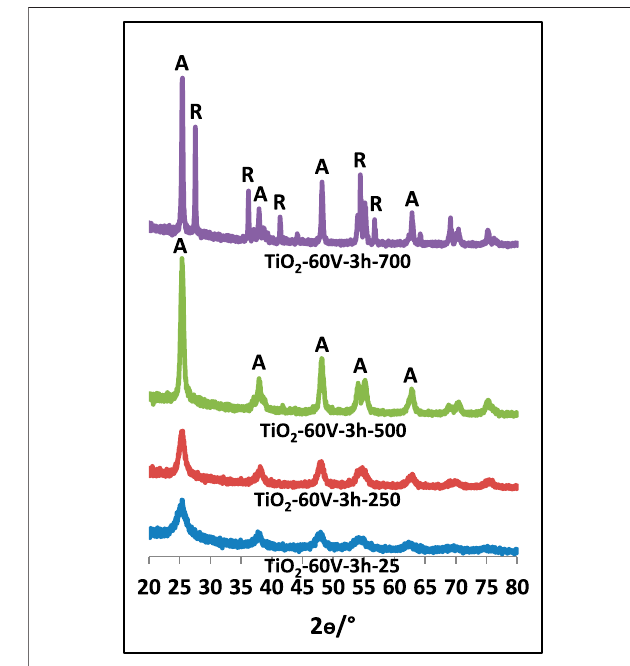
FIGURE 2 | XRD patterns of TiO 2 -60V-3h samples calcined at different temperatures.